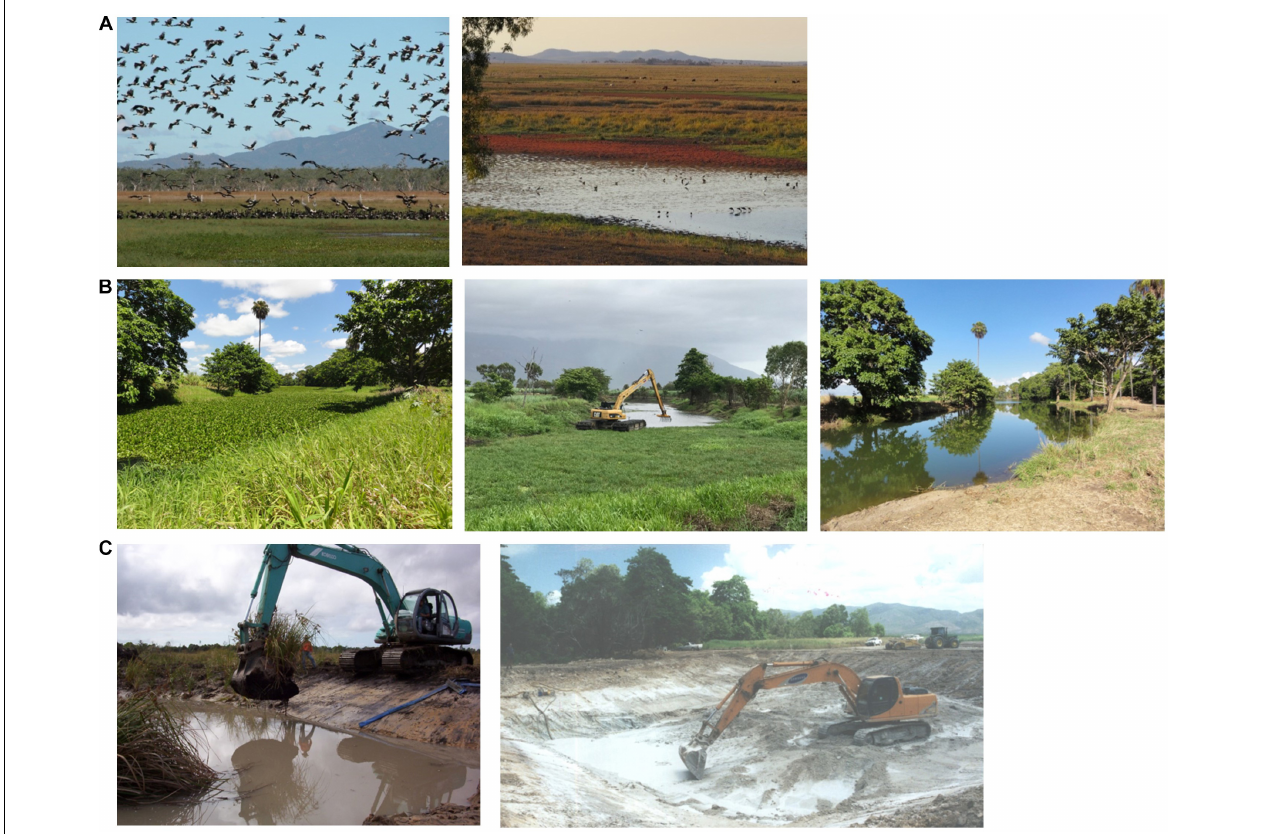
FIGURE 5 | Photographs illustrating restoration case studies: (A) bird habitat and cattle grazing in the Torilla floodplain (Photo credits: R. Jaensch); (B) aquatic weed removal in the Burdekin floodplain (Photo credits: P. Groves); and (C) Tully Murray floodplain constructing wetlands (Photo credits: R. Digman).